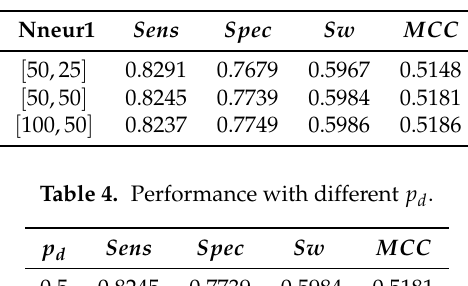
Table 3. Performance with different N neur .